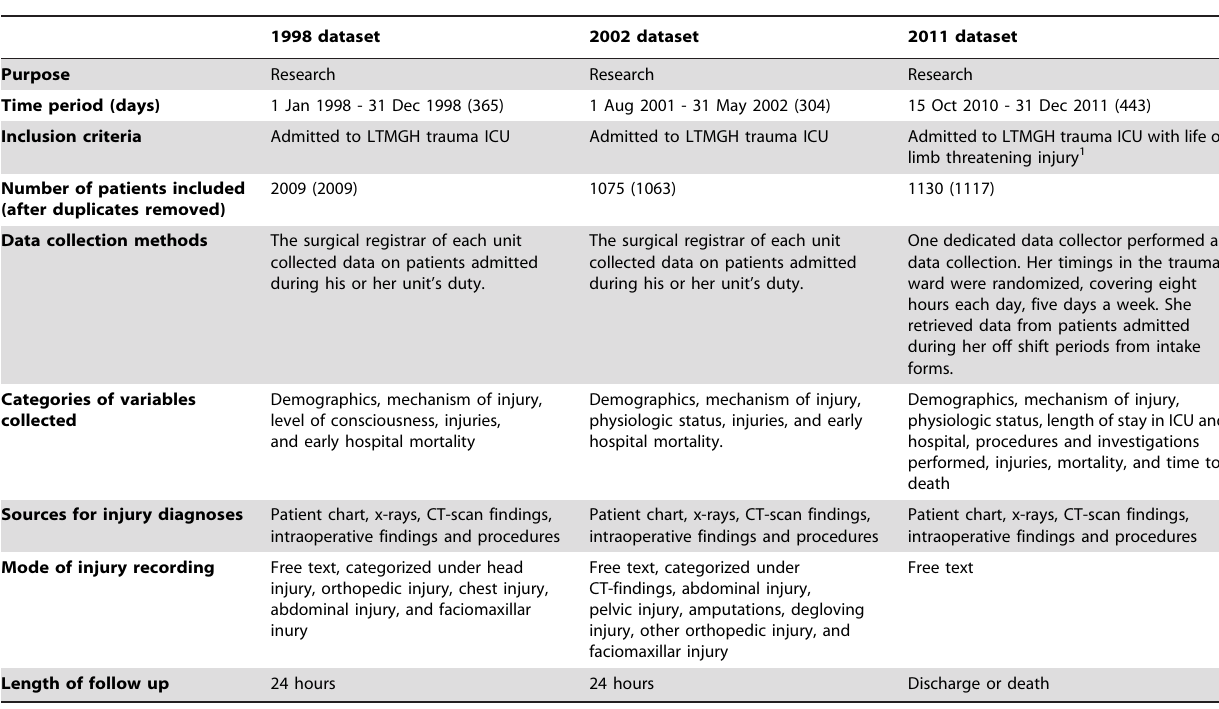
Table 1. Characteristics of the 1998, 2002, and 2011